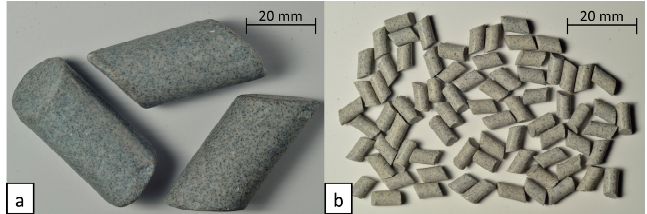
Figure 3. Media employed in the experimentation: big ( a ) and small ( b ) angled cut cylindrical ceramic media.